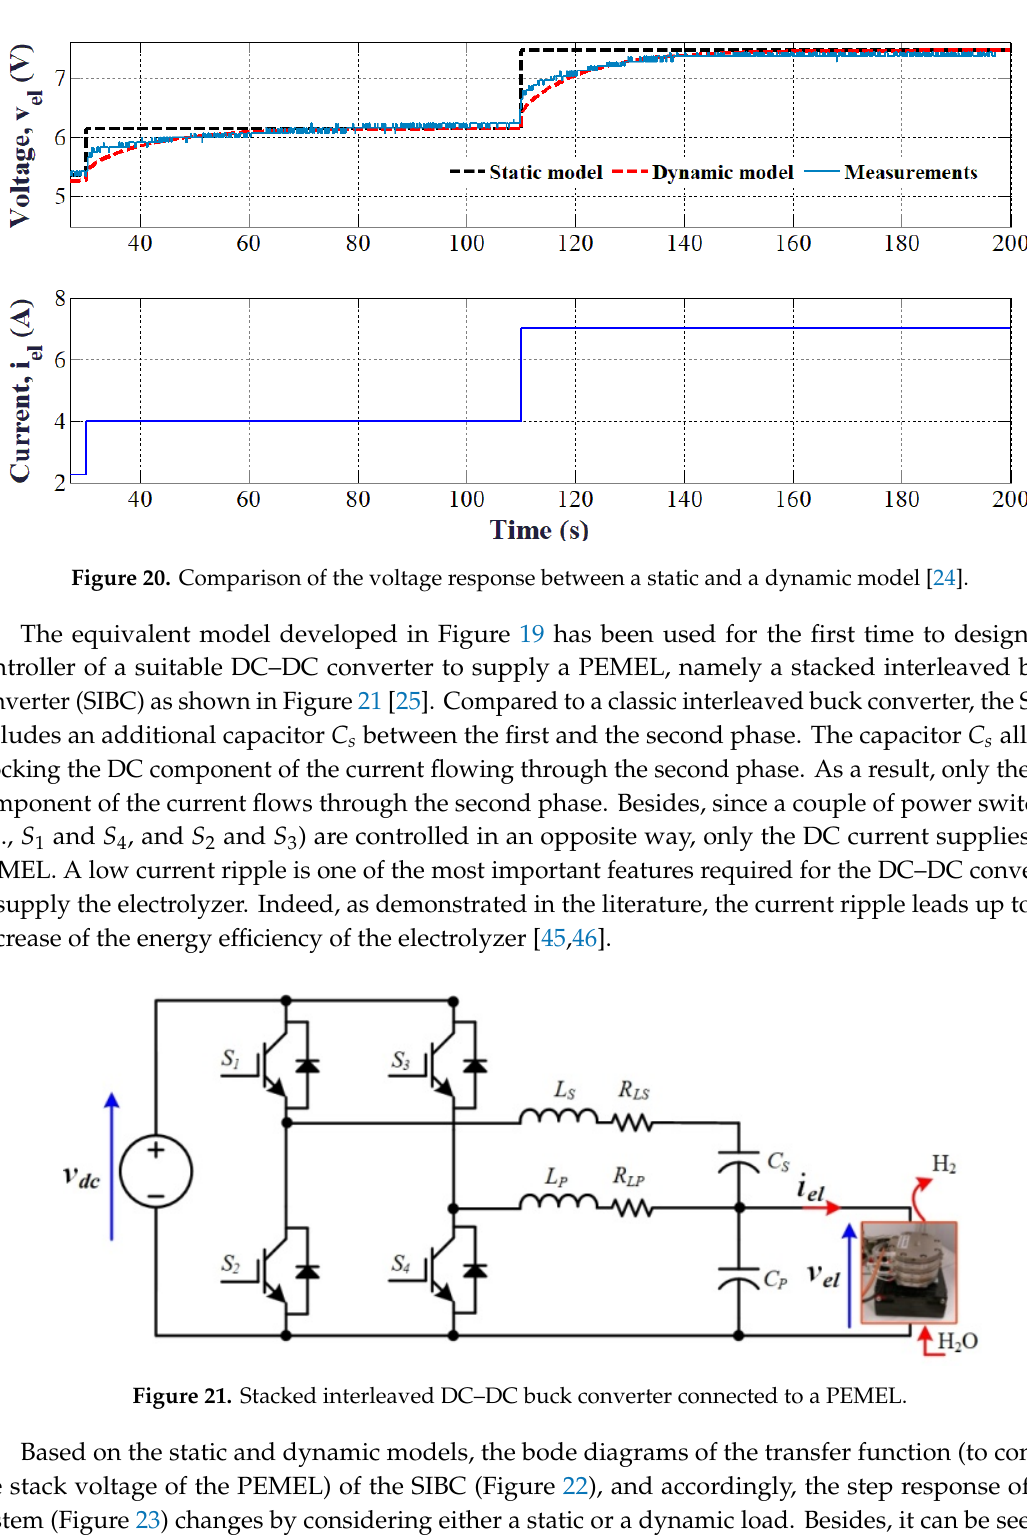
Figure 21. Stacked interleaved DC–DC buck converter connected to a PEMEL.